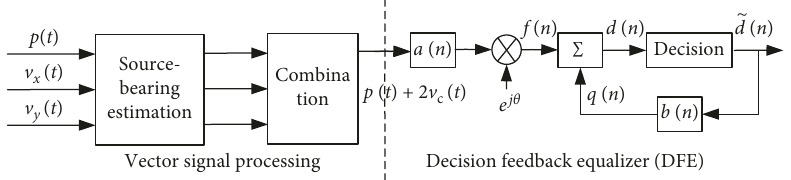
Figure 3: The block diagram of B-DFE.